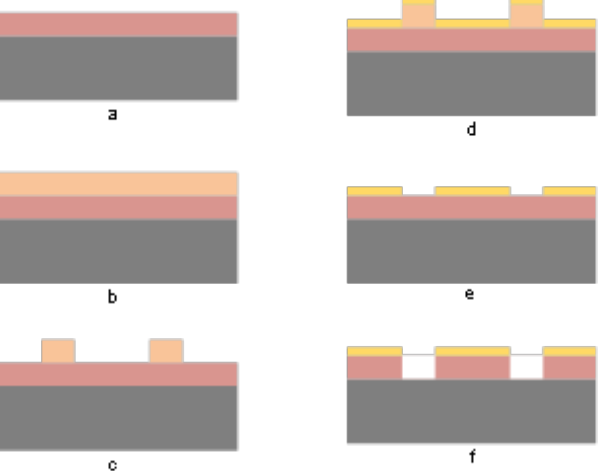
Figure 1. The micro-vias fabrication process: ( a ) PI spun-coated on SiO 2 wafer; ( b ) PR spun-coated on PI film; ( c ) lithography and development of PR; ( d ) Ti/Cu/Cr hard mask deposition; ( e ) residual PR lifted-off; ( f ) ICP plasma dry etching of